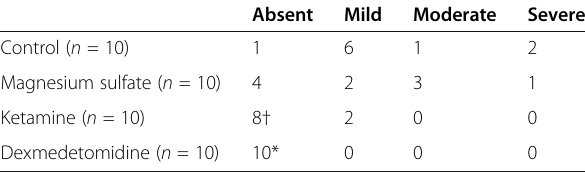
Table 3 Comparison of study groups in terms of inflammation Absent Mild Moderate Severe